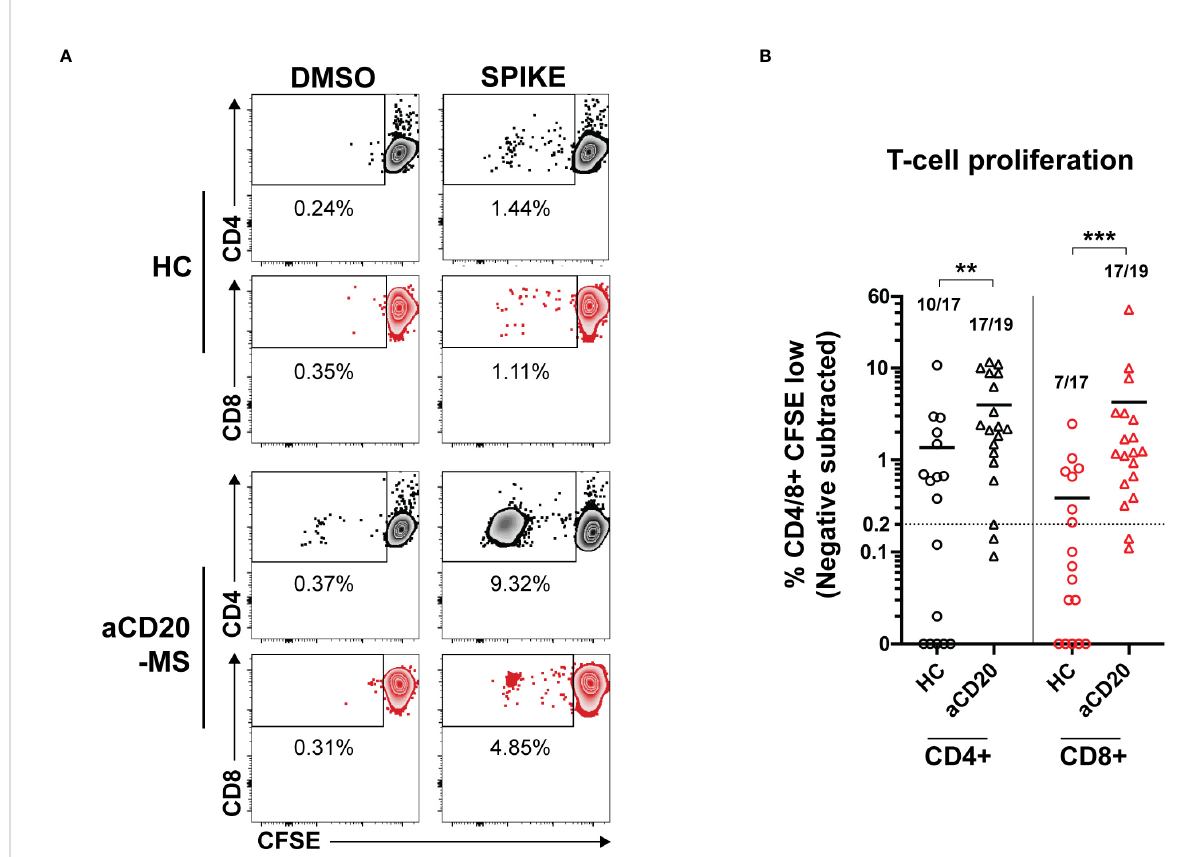
FIGURE 4 Increased ex vivo T-cell proliferation after stimulation with CoV-2 spike peptide pool in aCD20-MS patients compared to healthy control group. (A, B) PBMCs from healthy controls (n=17) and aCD20-MS patients (n=19) were stained with CFSE dye and stimulated with DMSO negative control (0.4%), and full overlapping spike peptide pool (1 µg/mL) for 6 days. (A) Representative fl ow cytometry data for the detection of CFSE- low proliferating CD4 + (grey) and CD8 + (red) T-cells after antigen incubation of PBMCs from one aCD20-MS patient and one healthy control individual. See also Figure S6. (B) Comparison of magnitude of proliferative CD4 + (black) and CD8 + (red) T-cells responses after exposure to overlapping spike peptide pool. Data is presented as %CD4/8 + CFSE-low, with DMSO negative control values subtracted. Only test samples with %CD4/8 + CFSE-low value above 1.5X negative control and higher than 0.2% after negative subtraction were considered positive. Fractions of samples above positivity cut-off are indicated on top of each dataset. Horizontal lines inside graph represent mean values. Calculated P values are as follow: **P < 0.01, ***P < 0.001; Mann-Whitney U